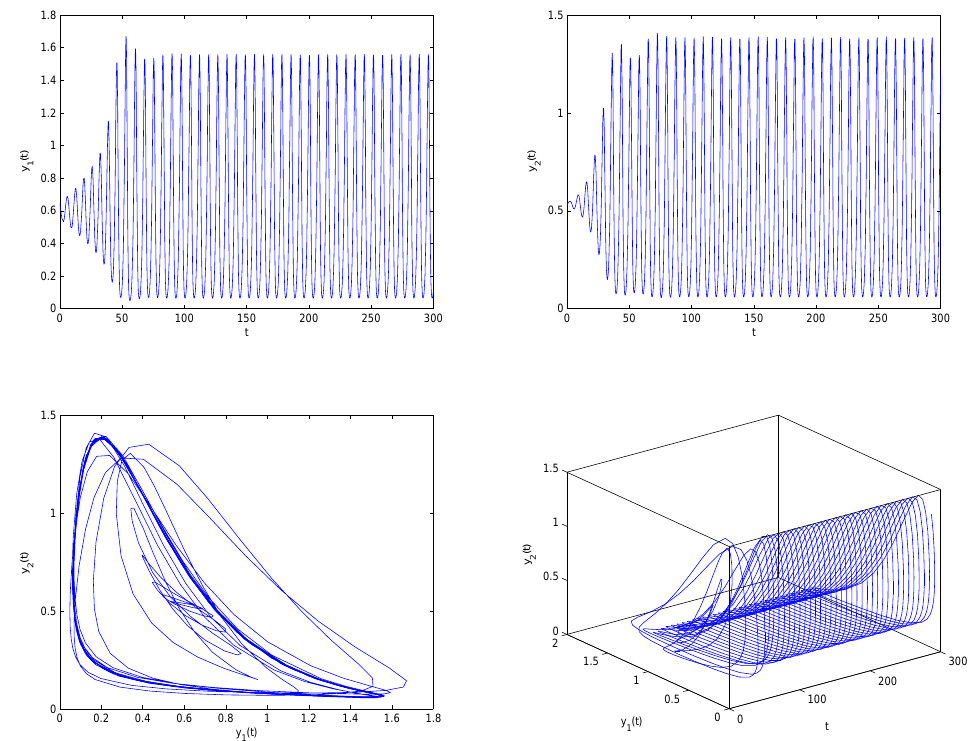
Figure 5. Numerical simulation results of model (63) concerning θ = 1.1 < θ 0 equilibrium point Y ( 1.0221,16.0947 ) remains at a locally asymptotically stable level.